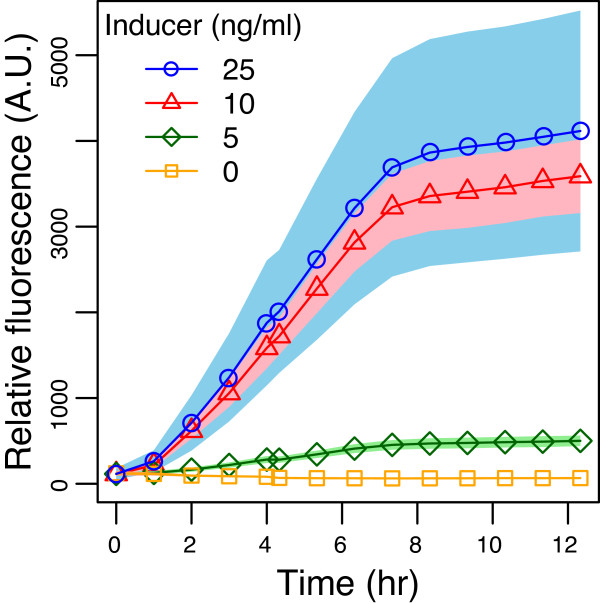
Expression of GFP with time for various inducer levels. Open circles, triangles, diamonds and squares correspond to 25, 10, 5 and 0 ng/ml induction. Expression levels corresponding to 1 and 0.1 ng/ml were not significantly different from the 0 ng/ml expression level, and are omitted from the plot. Shaded regions outline two standard deviations around the mean. Additional file 1: Figure S6 shows that the growth rates for the different inducer levels were statistically identical.